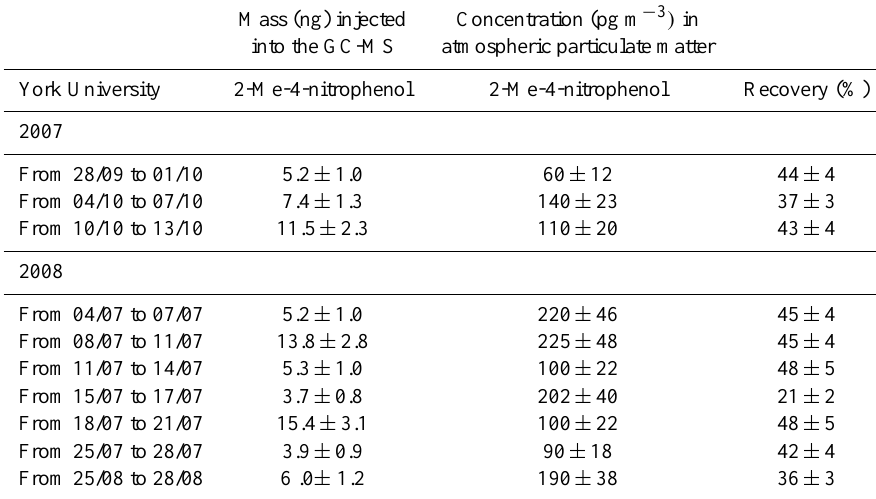
Table 6. Mass (ng) of 2-methyl-4-nitrophenol in 1µl of the final solution from extraction of filters collected at York University and the corresponding concentrations in the